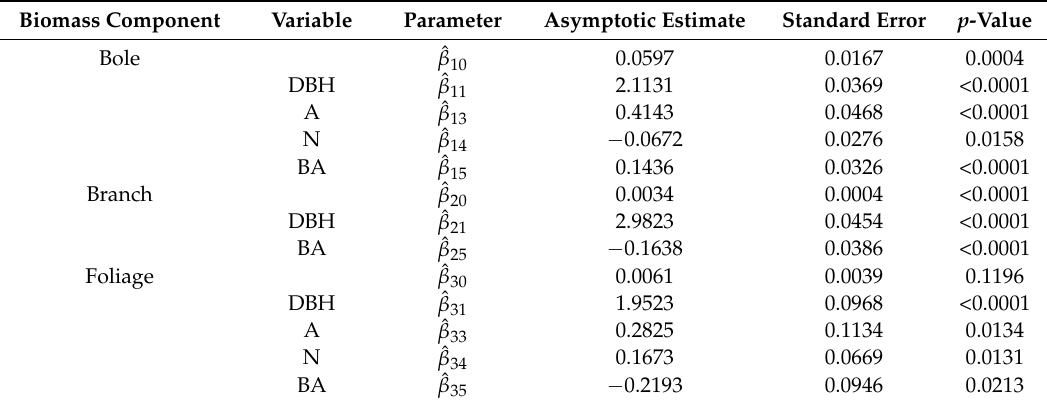
Table 7. Parameter estimates and their asymptotic standard error and p- values for the additive biomass equation system based on diameter at breast height (DBH), age (A), number of trees per hectare (N) and basal area (BA) (Model System